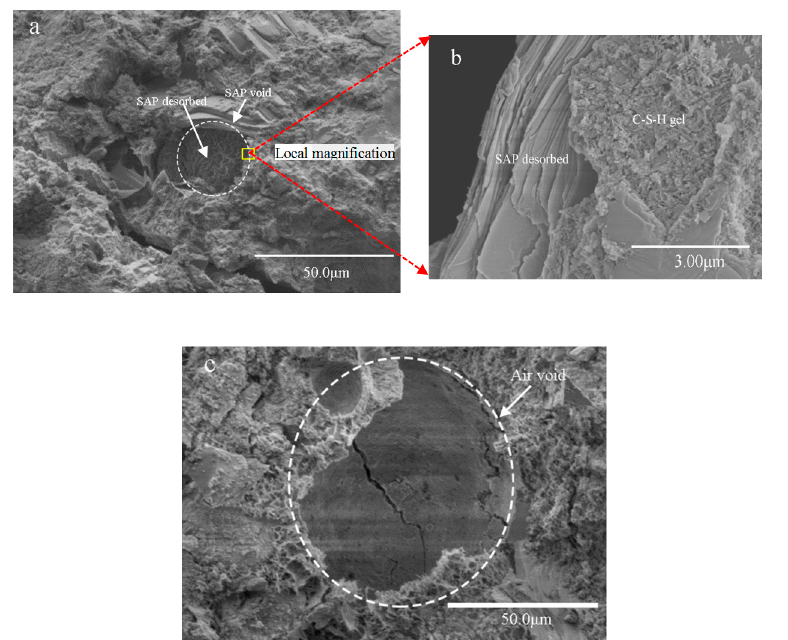
Figure 4. SEM images of cement paste with the addition of powdery SAP at 28 days: ( a ) microscopic structure of the SAP void; ( b ) microscopic interface between the SAP and hardened mortar; ( c ) microscopic structure of the air void.